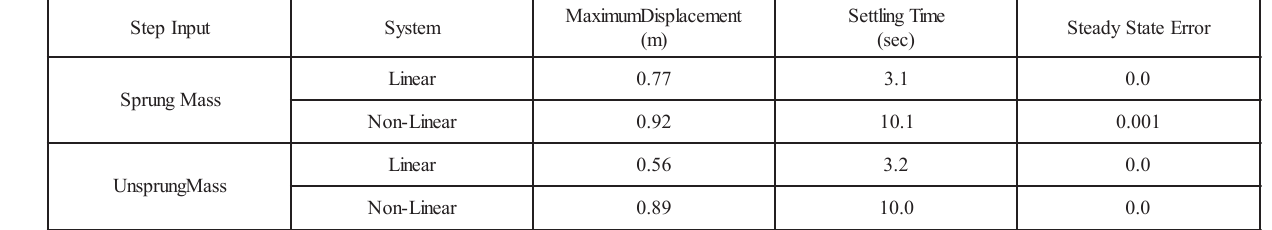
TABLE 4. TRANSIENT RESPONSE FOR STEP